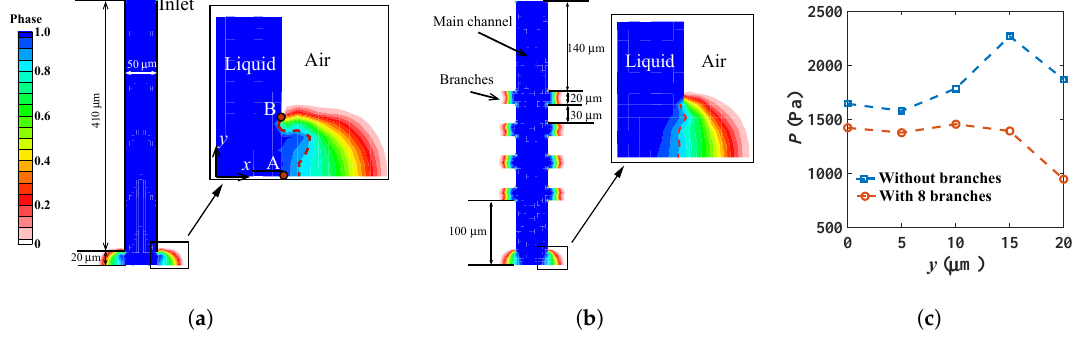
Figure 3. Simulations on the fluid flow in the main channel: ( a ) without branches; and ( b ) with eight branches. ( c ) The pressure along Point A to Point B shown in ( a ). Table 1. Physical conditions of water and air